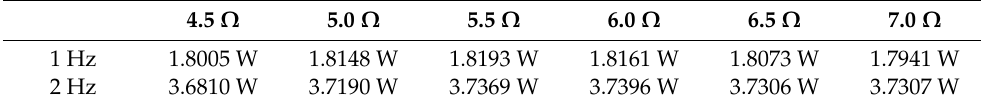
Table 3. Output electrical energy with different load